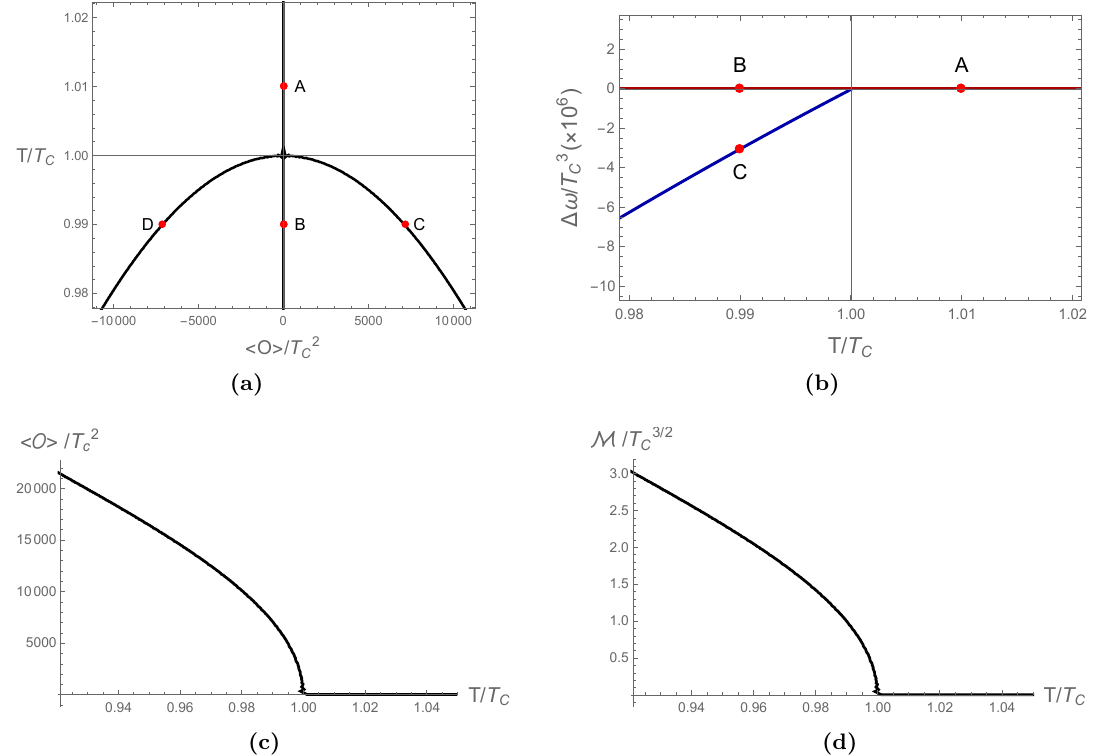
Figure 1 . (a) The set of black brane solutions satisfying zero source condition (b) The di(cid:11)erence of free energy of RN black branes (red) and hair black branes (blue). (c) Temperature dependence of the absolute value of the condensation. (d) Temperature dependence of the absolute value of the magnetization, where we took (cid:18) = (cid:0) 0 : 2 for numerical